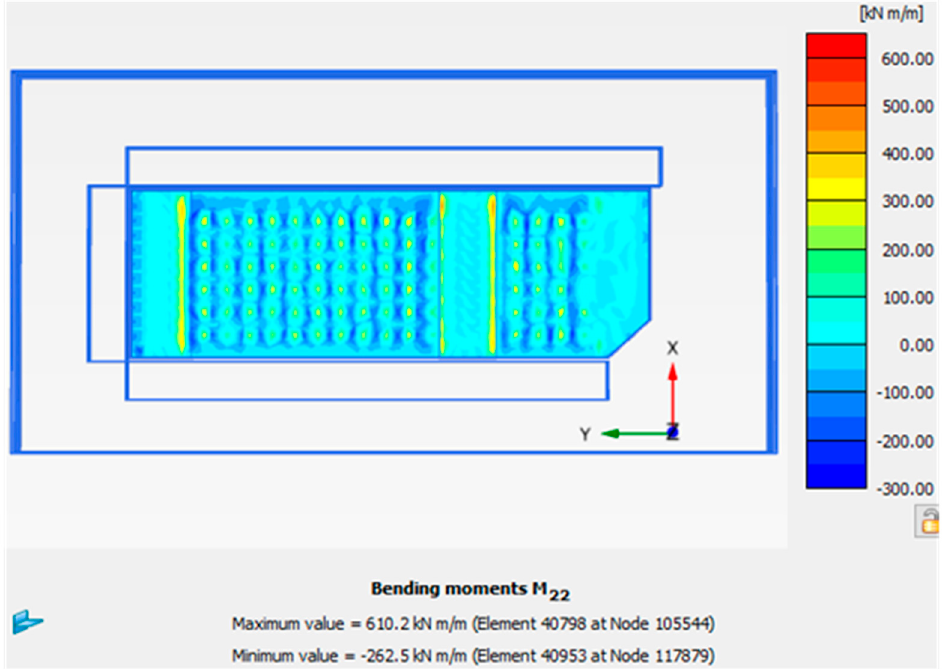
Figure 18. Nephogram of the bending moment in the entire raft of the high-rise buildings.